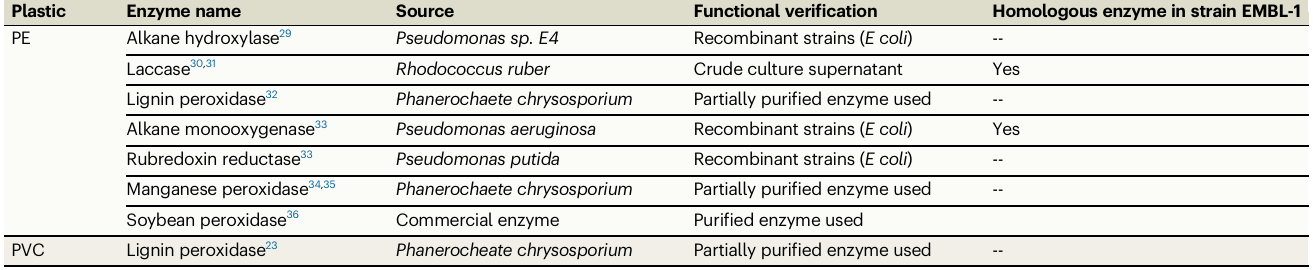
Table 1 | Literature review showing a limited understanding of polyvinyl chloride (PVC)-degrading microbial strains and enzymes relative to those for polyethylene (PE)